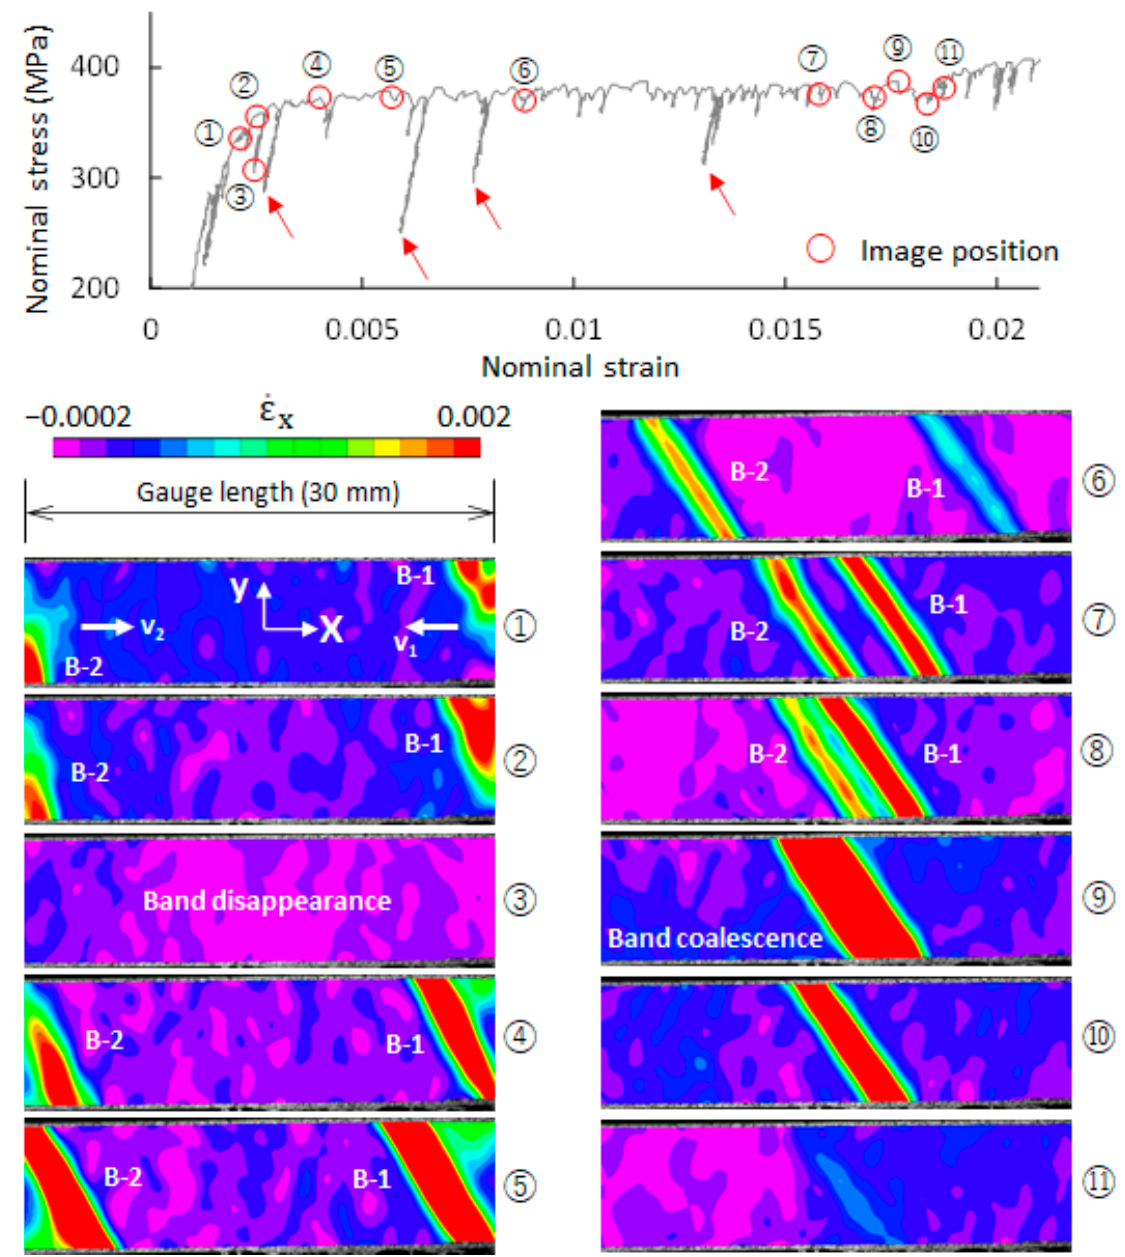
Figure 3. Evolution of plastic bands in ferrite/pearlite steel (F ‐ 1 specimen). Eleven images ( ① to ⑪ ) on the macroscopic stress–strain curve were taken. Their strain ‐ rate fields over the gauge length (30 mm) show the evolution of plastic bands.